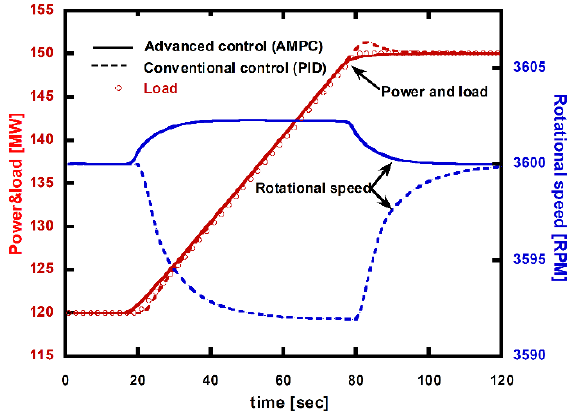
Figure 17. Simulated variations in gas turbine power and rotational speed with increasing load (ramp rate: 30 MW/min).